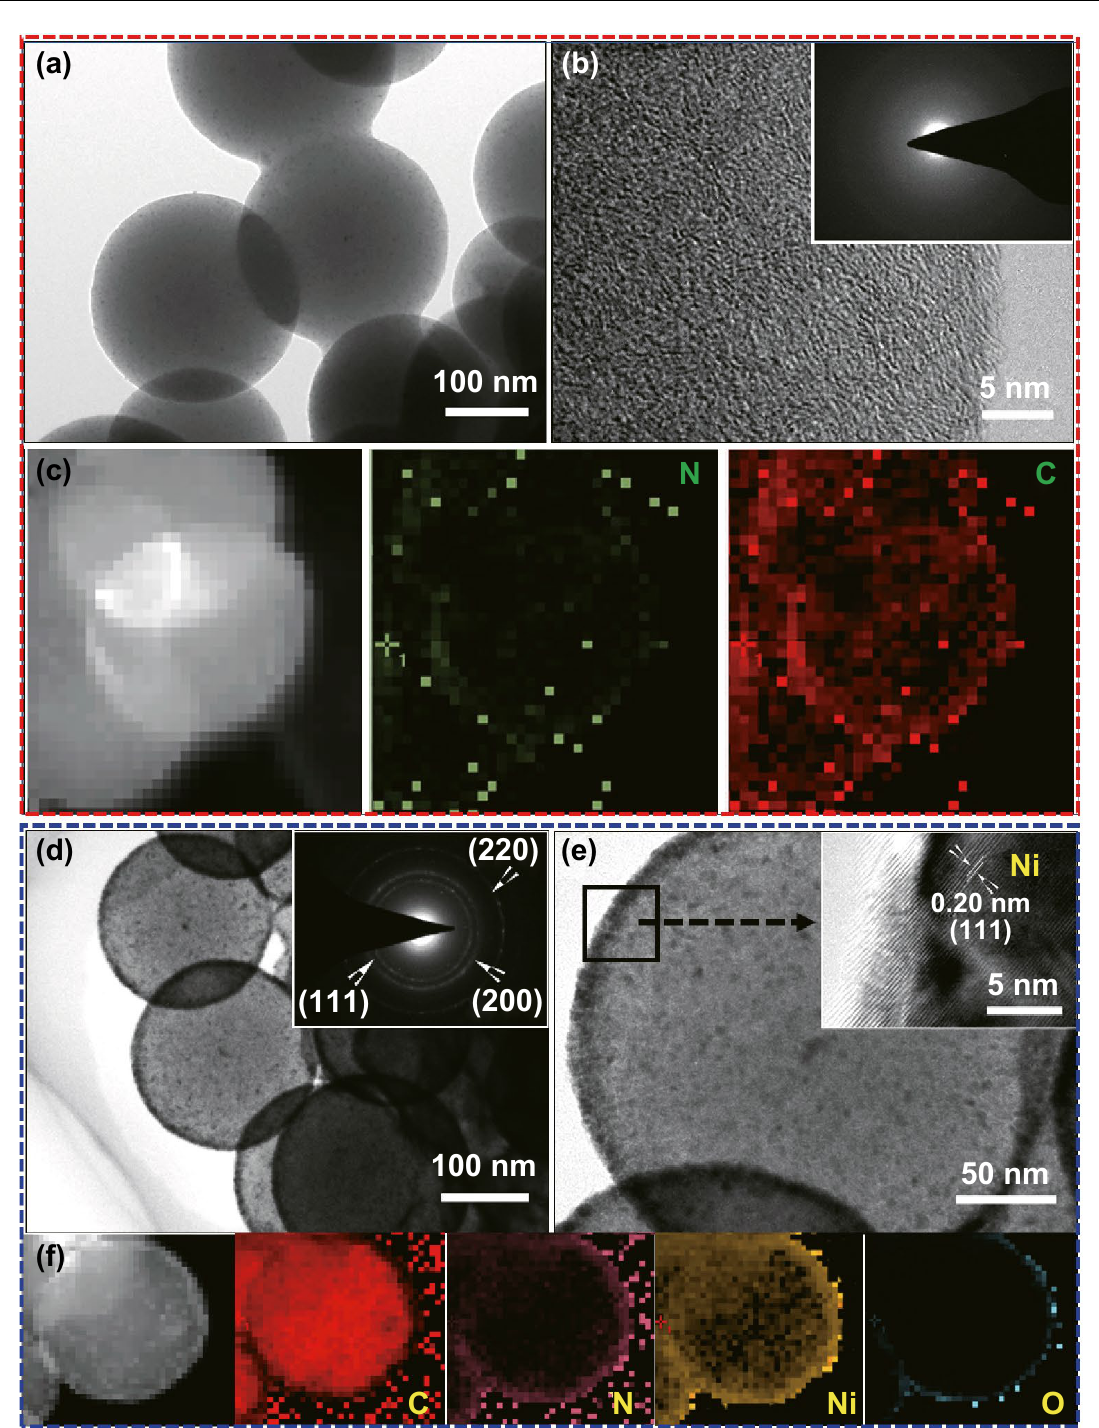
Fig. 2 a , b TEM-HRTEM images and c EDS elemental mapping images of N-CNSs films. d , e TEM-HRTEM images and f EDS elemental mapping images of